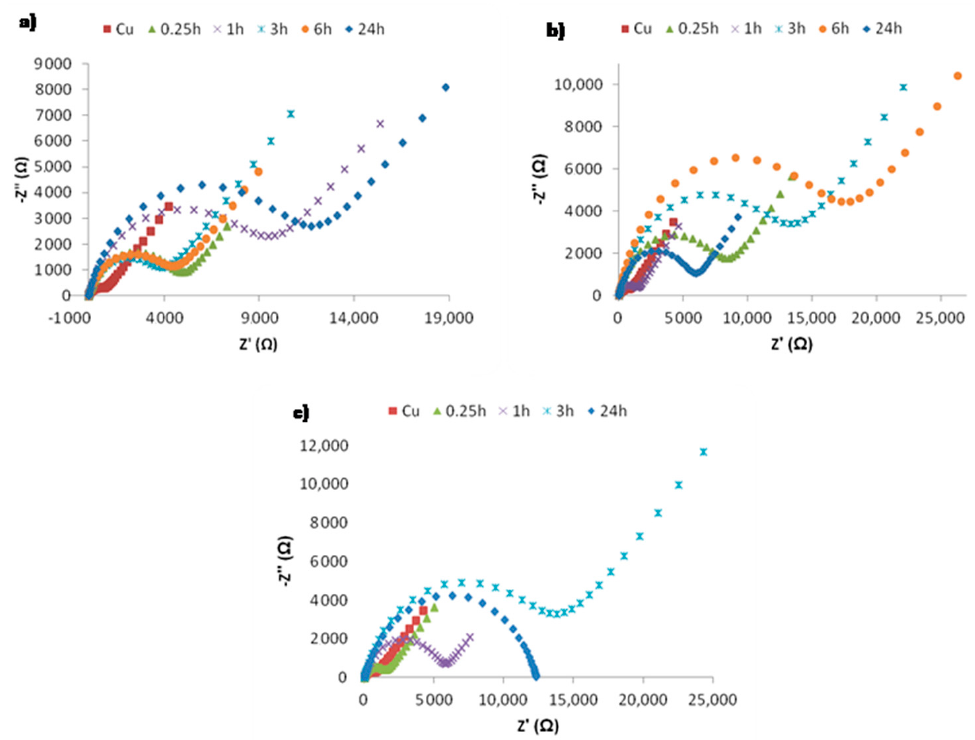
Figure 2. ( a – c ) Nyquist diagrams for Cu electrode in acid aqueous solution of H 2 SO 4 0.1 M, unmodified and modified with self-assembled monolayer of ( a ) hexyl-, ( b ) octyl- and ( c ) decylphosphonic acids immersed in their solutions with concentration 1 mM in ethanol with different immersion times.